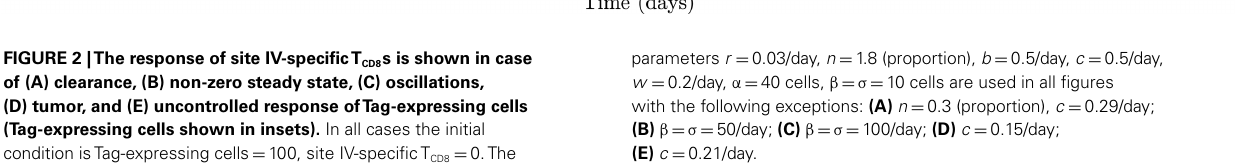
parameters r = 0.03/day, n = 1.8 (proportion), b = 0.5/day, c = 0.5/day, w = 0.2/day, α = 40 cells, β = σ = 10 cells are used in all figures with the following exceptions: (A) n = 0.3 (proportion), c = 0.29/day; (B) β = σ = 50/day; (C) β = σ = 100/day; (D) c = 0.15/day; (E) c =